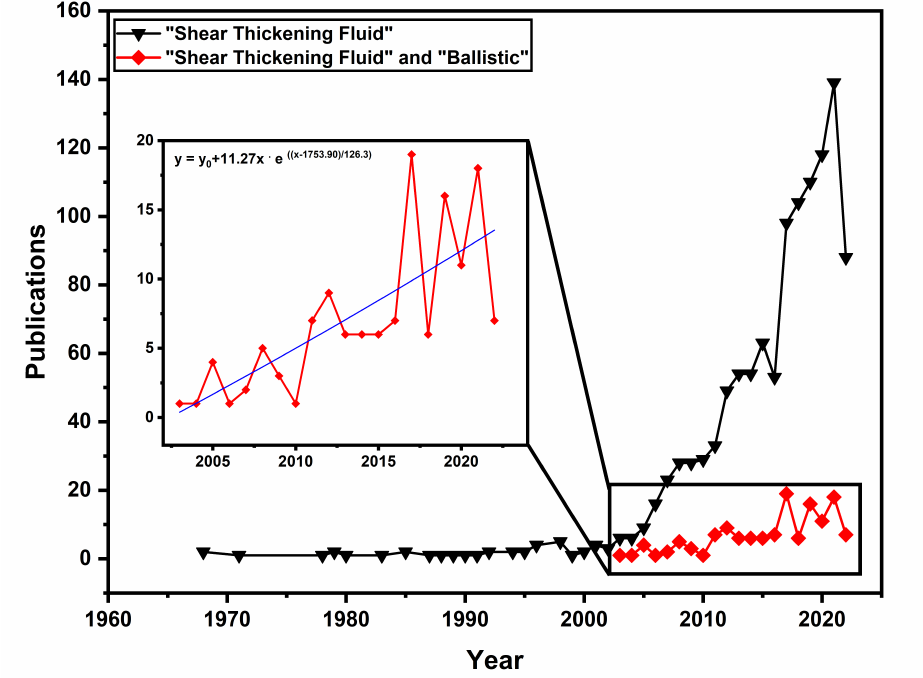
Figure 1. Publications per year for different keywords using the Scopus database. The black line represents the number of publications with the keyword “Shear Thickening Fluid”, while the red line represents the keywords “Shear Thickening Fluid” and